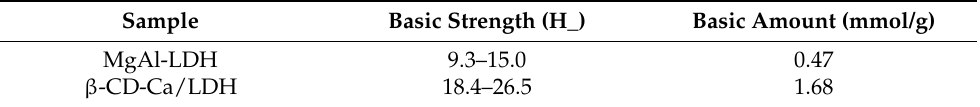
Table 3. Basic strength and basic amount of MgAl-LDH and β